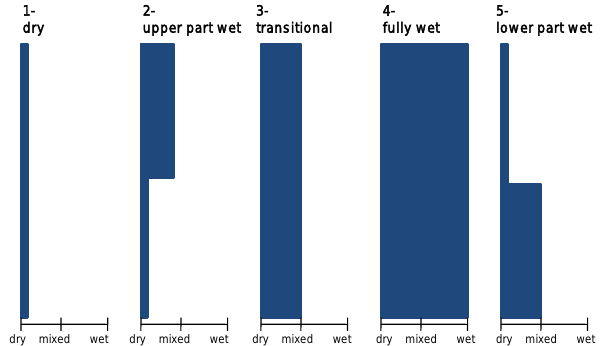
Fig. 13. Wetness classification incorporating vertical and horizontal water content distribution. The x-direction shows the percentage of the snow which has been wetted, where dry/wet is fully dry or fully wet and mixed consists of both dry and wet regions. The y-direction shows the vertical distribution of snow wetness (50–100cm). Diur- nal changes occur mostly within the upper-most 10–15cm of the snowpack and are not considered in this